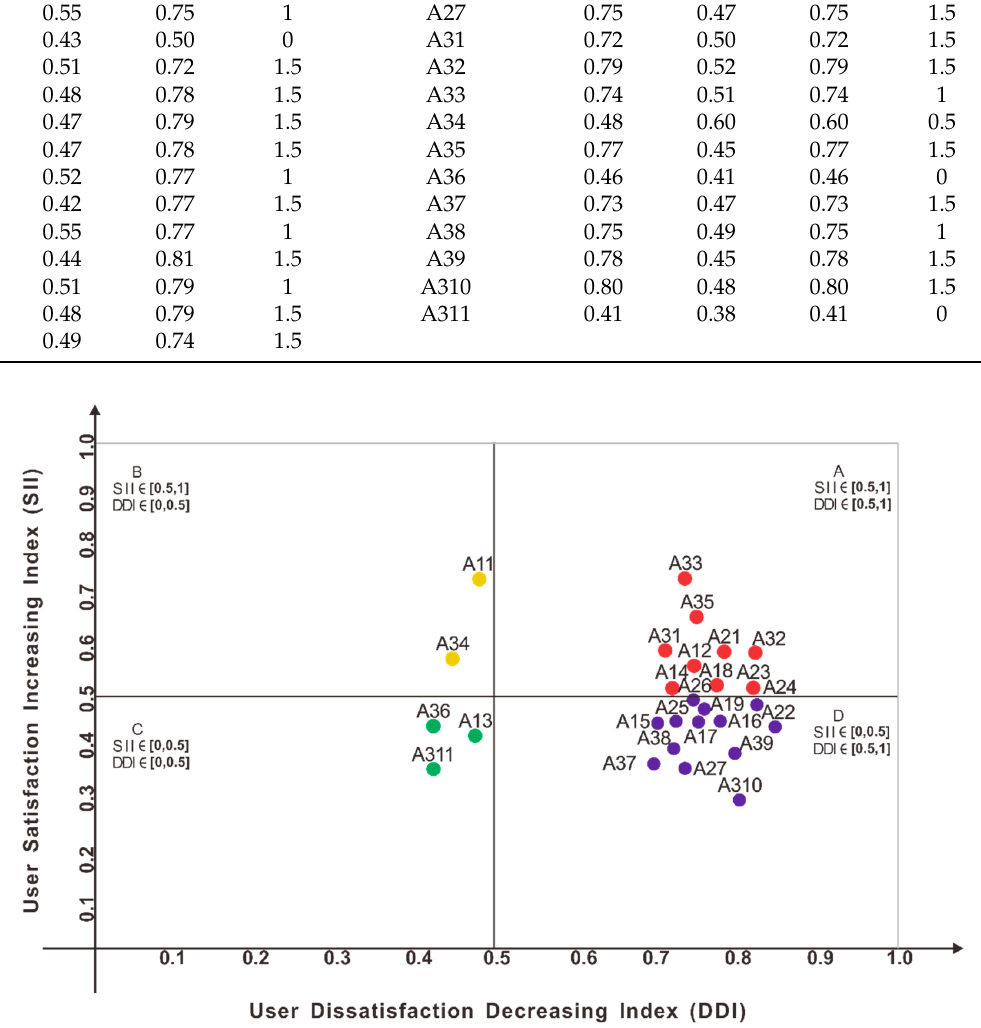
Figure 5. User satisfaction numerical coordinate distribution map.